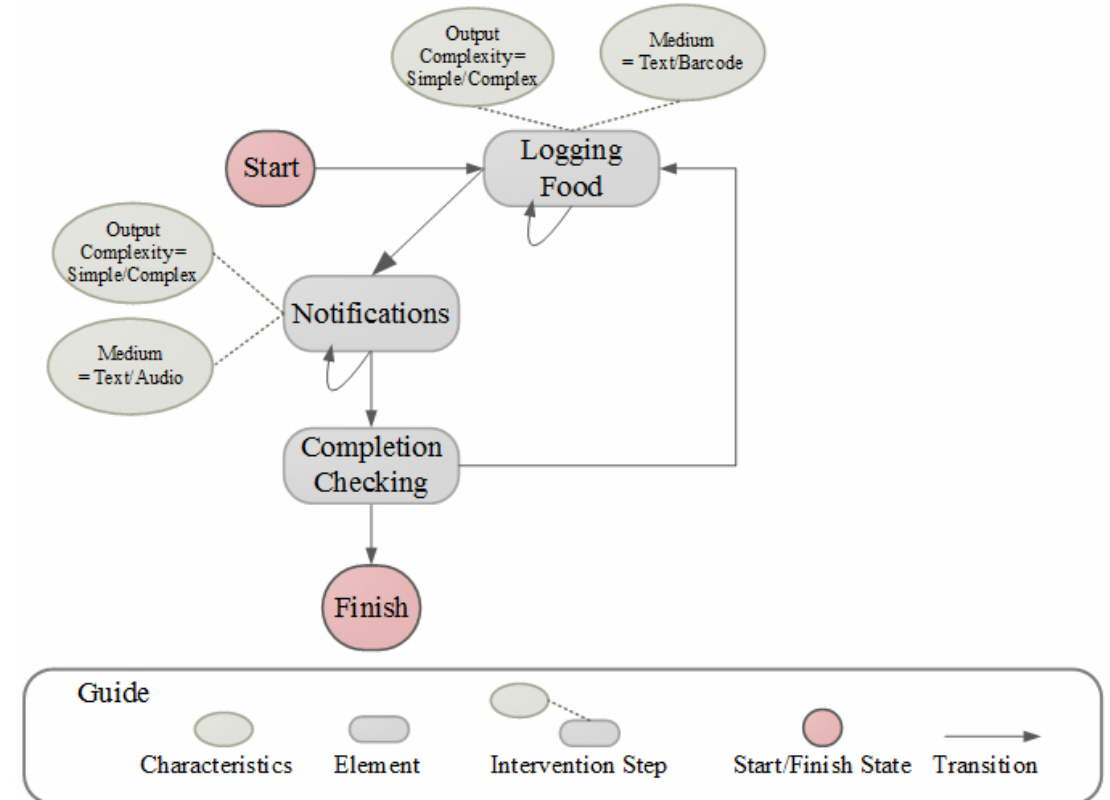
Figure 6. Workflow for MyFitnessPal specifying the elements (rectangular nodes), element’s characteristics (elliptical nodes), as well as order of transitions among